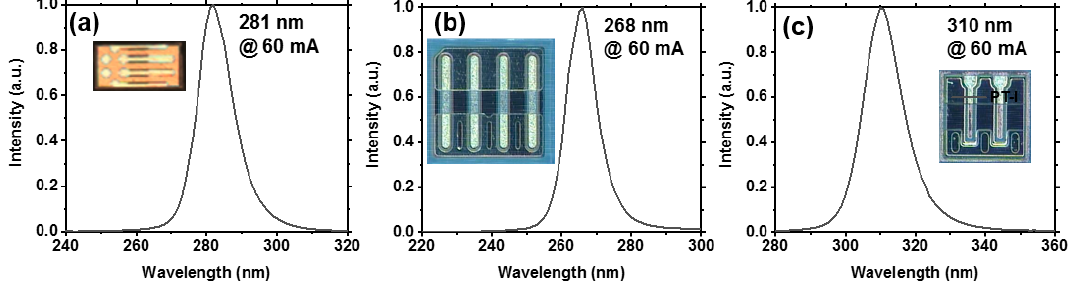
Figure 5. Three different wavelength DUV-LEDs and their spectra at 60 mA.